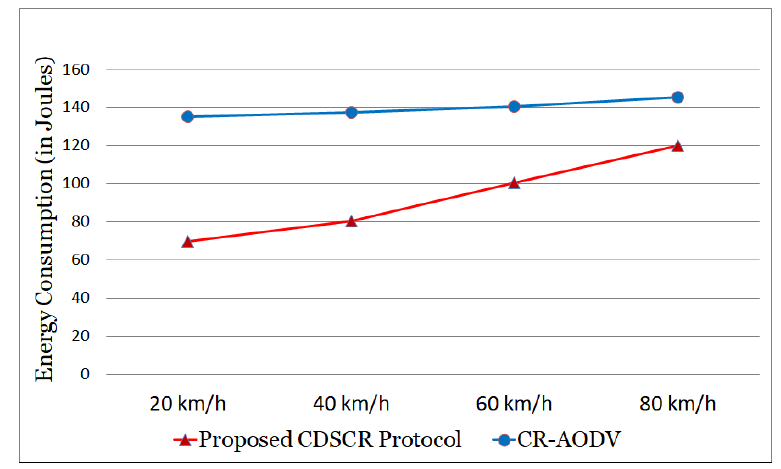
Figure 14. Energy Consumption (in Joules) versus node